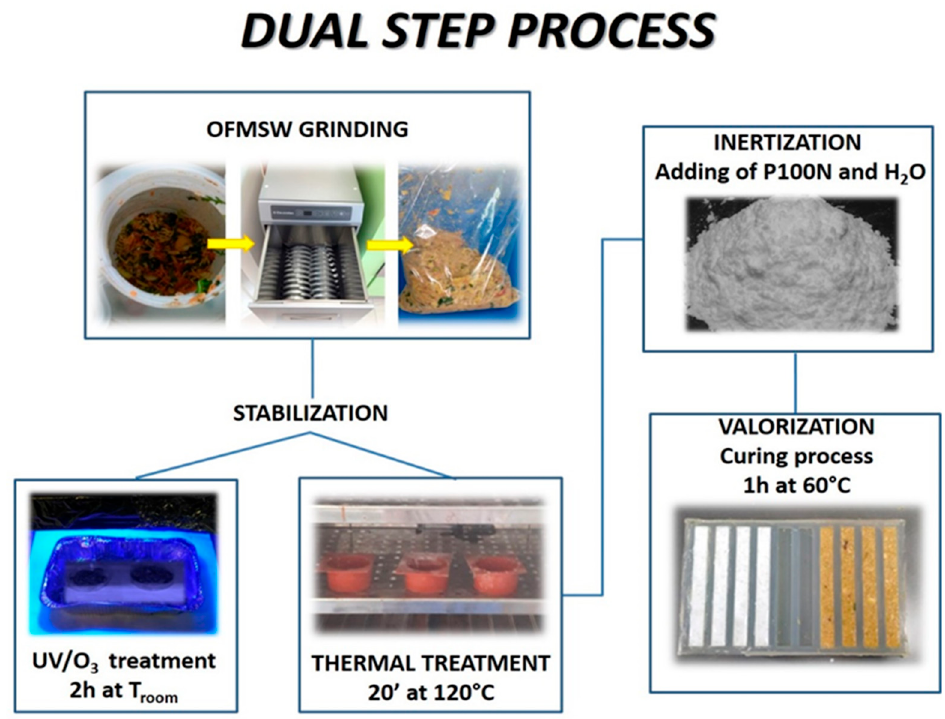
Figure 1. Simplified scheme relative to the dual-step OFMSW-treatment process.